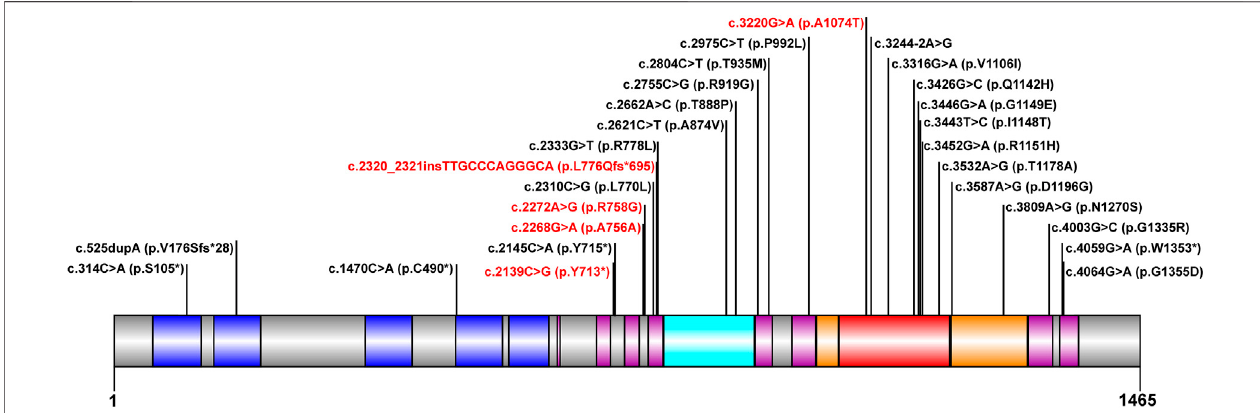
FIGURE 1 | Scheme of ATP7B with functional regions and mutations reported in our cohort. The metal binding unit, transmembrane domain, actuator domain, phosphorylation domain, and nucleotide-binding domain are colored in blue, purple, cyan, orange, and red, respectively. The novel mutations detected in this study are in